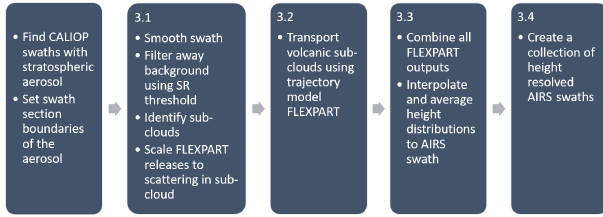
Figure 4. Flowchart of our